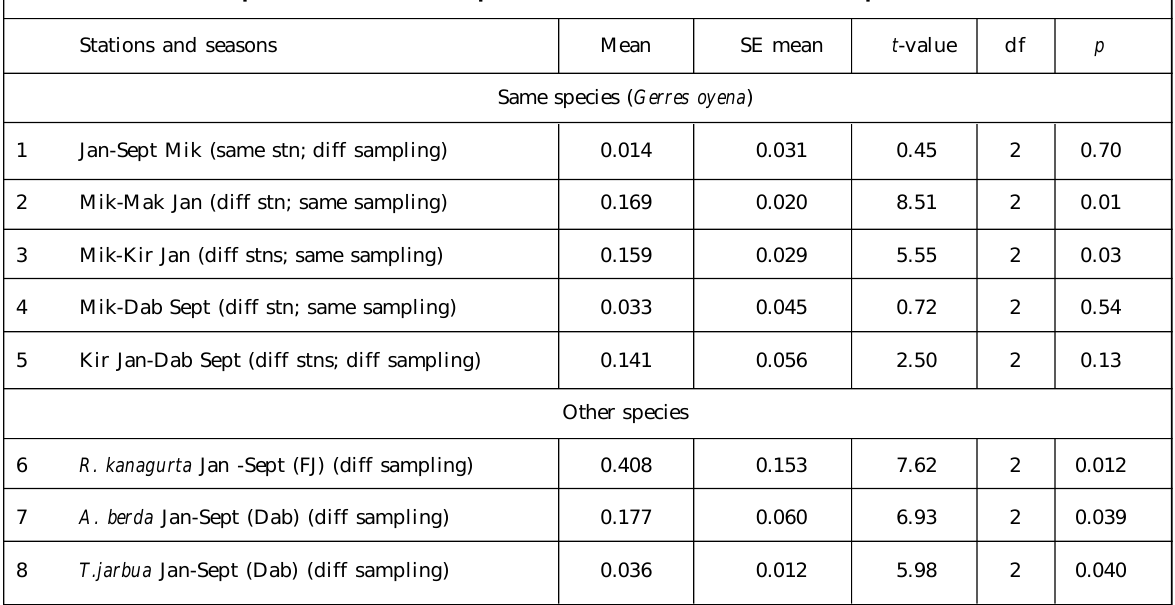
Table 6: Pairwise comparison of Mean microplastic concentration (x ± SE) in fish species Stations and seasons